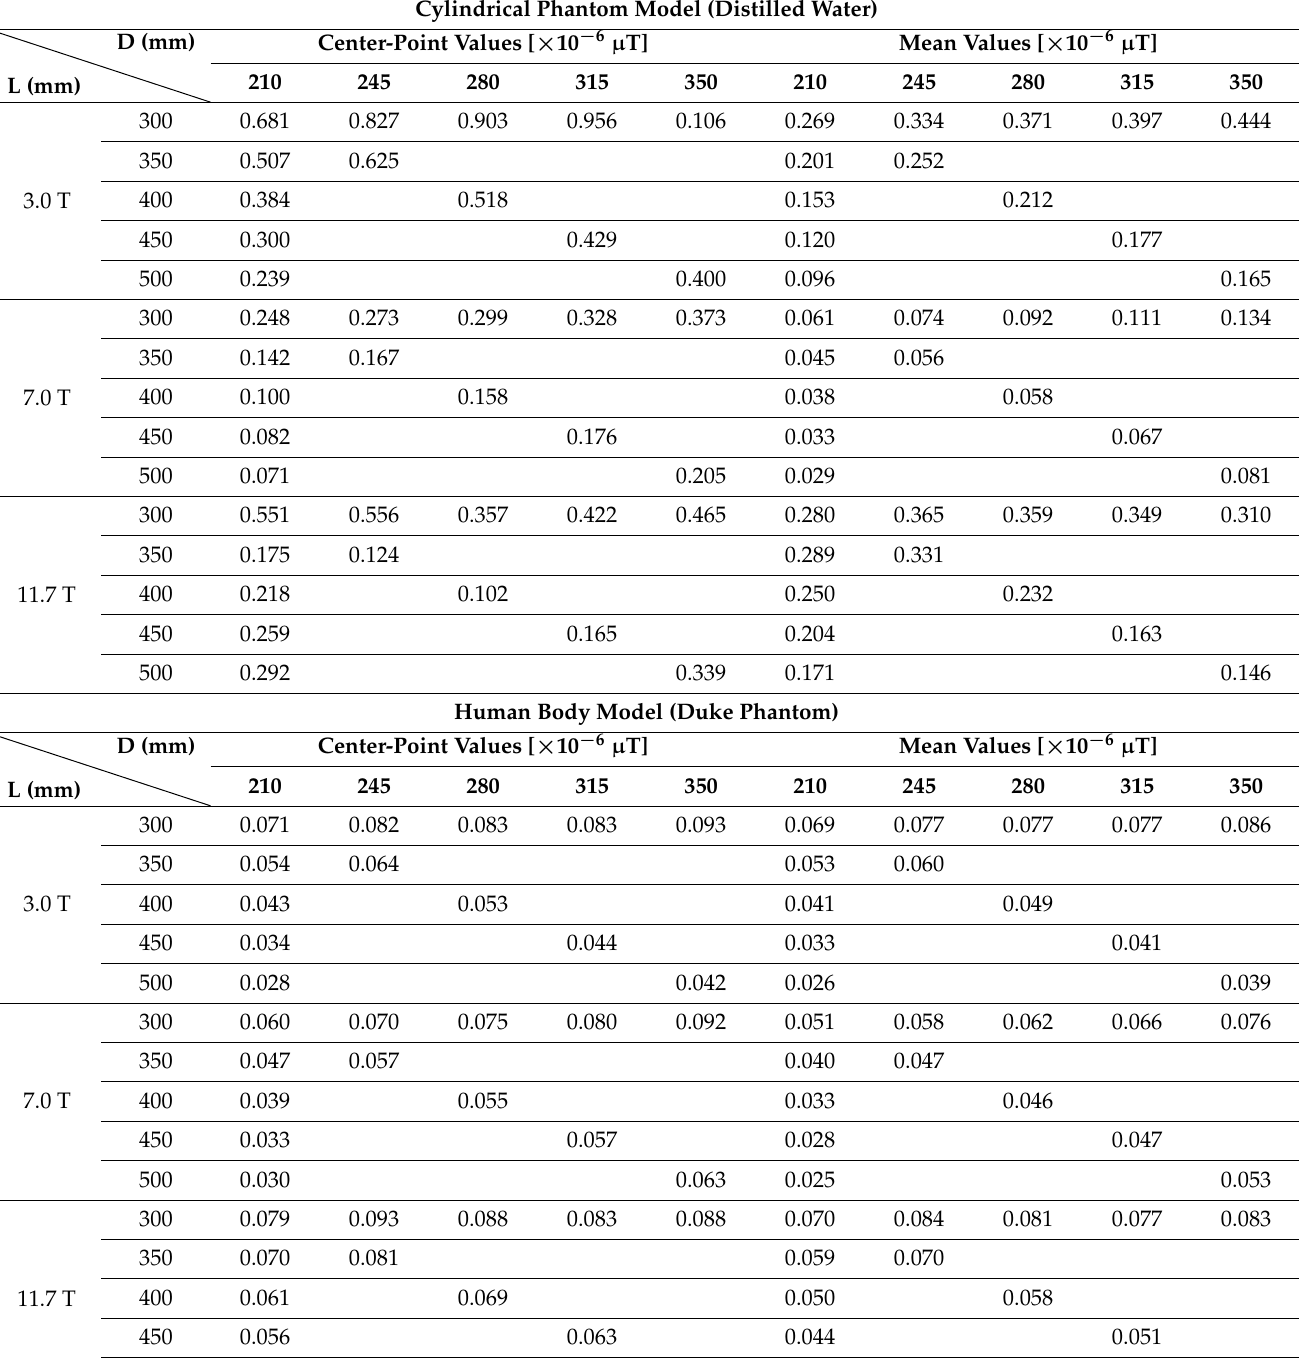
Table 1. Unnormalized |B 1+ |-field values obtained when using a cylindrical phantom model or a human body model at a 3.0, 7.0, or 11.7 T MRI